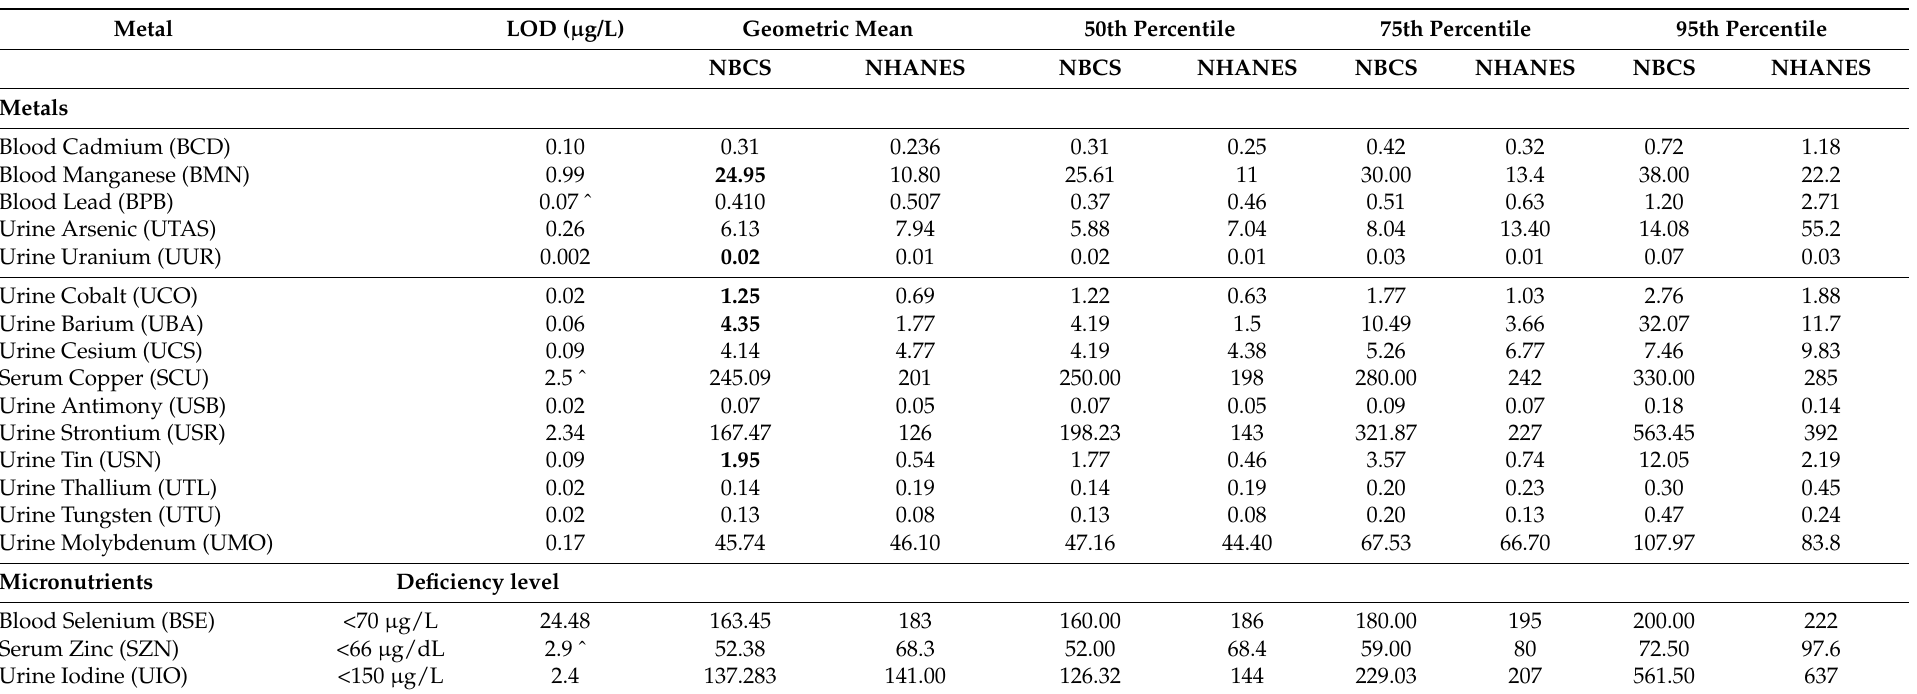
Table 1. Metal and micronutrient concentration distributions in pregnant 14–45-year-old women: NBCS results compared to 2011–2012 and 2013–2014 NHANES data